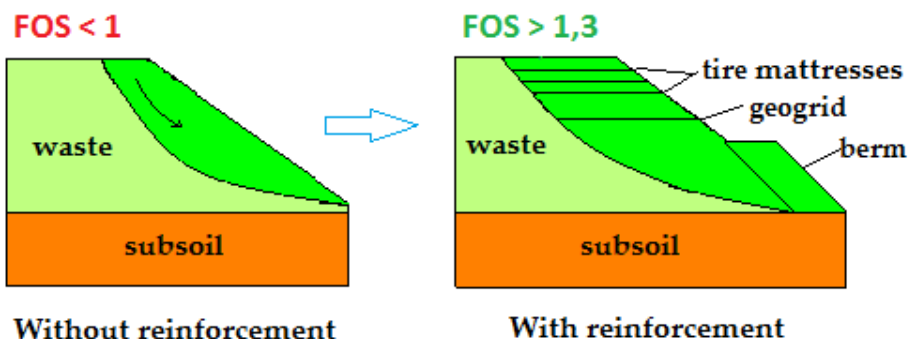
Figure 1. Lateral reinforcements of landfill slope to improve the factor of safety (FOS).